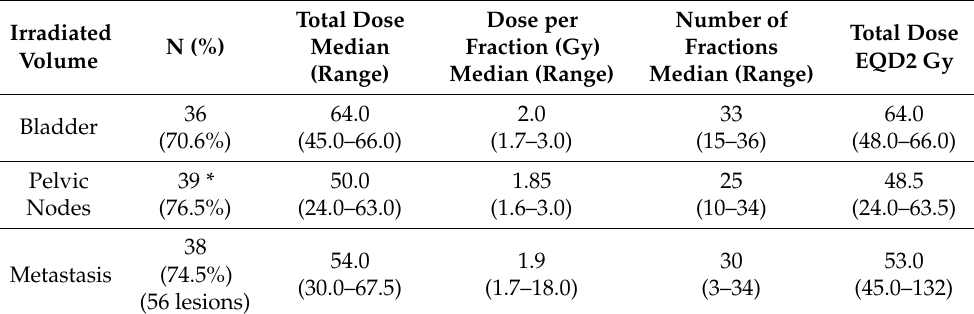
Table 2. Details of local consolidative radiotherapy in the IR group (n =